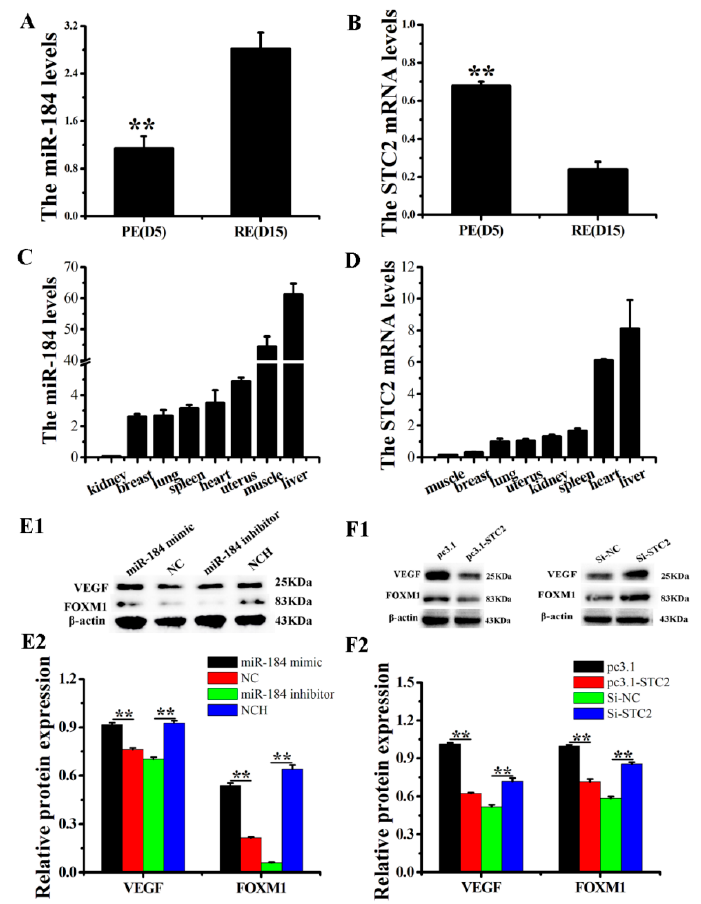
Figure 1. The expression levels of miR-184 and STC2 in dairy goats. ( A ) The expression of miR-184 in PE and RE in dairy goats. ( B ) The expression of STC2 in PE and RE in dairy goats. ( C ) The expression of miR-184 in various tissues of dairy goats. ( D ) The expression of STC2 in various tissues of dairy goats. After transfection with miR-184 ( E1 , E2 ) or STC2 ( F1 , F2 ), WB analyzed the protein expression levels of VEGF and FOXM1. Stem-loop RT-qPCR was used to detect the expression of miR-184, which was standardized to that of U6. RT-qPCR was used to detect the expression of STC2, which was standardized to that of β -actin. The WB was used to measure protein expression and the optical density method was standardized to the density of β -actin in the same lane. Data is expressed as the “mean ± SEM” of three values, ** p < 0.01; PE, pre-receptive endometrium; RE, receptive endometrium; SEM, standard error of the